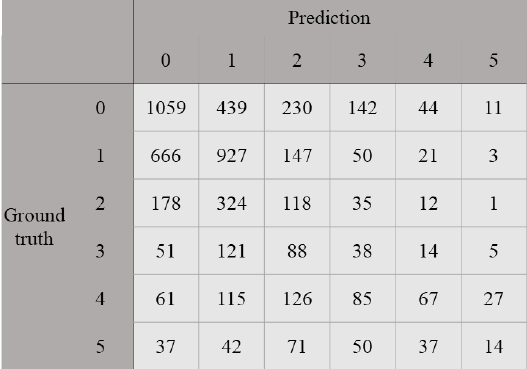
Figure 2. Confusion matrix of the proposed CNN between the ground truth and predicted labels in the test set . Note: EfficientNet B3 with LDL ( D = 60) was used.